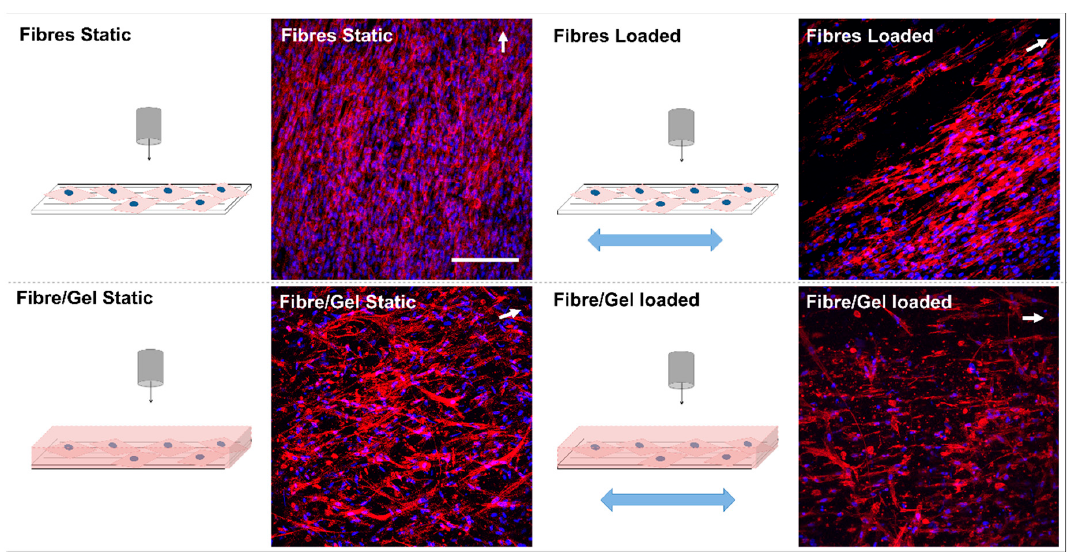
days. In contrast, cells largely remained at the interface for cyclically stimulated composites.